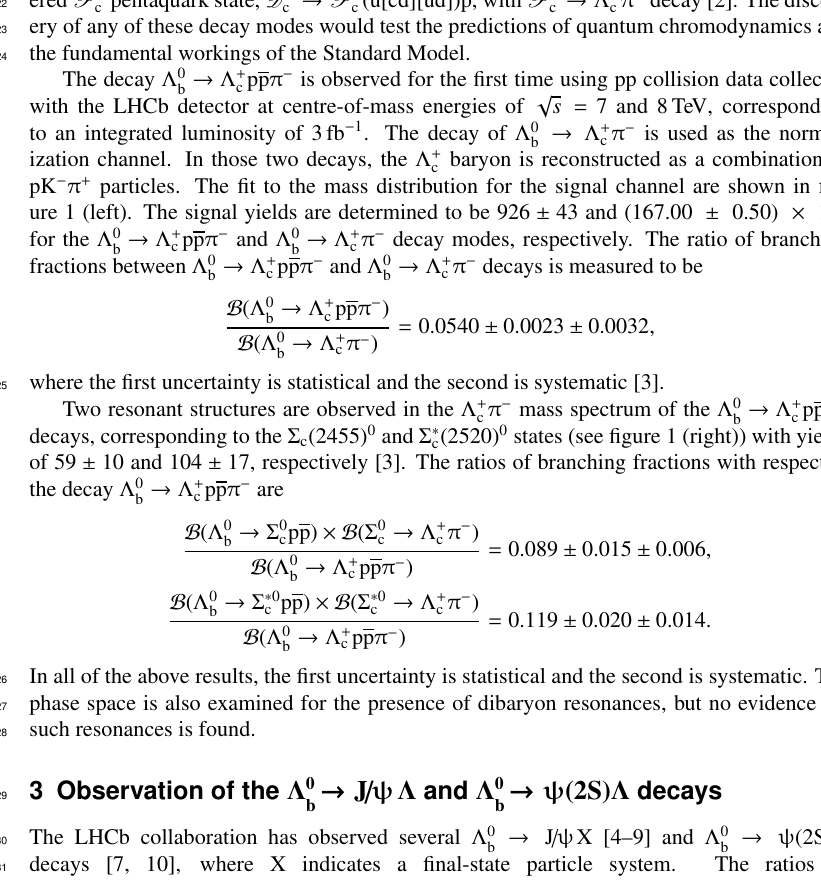
Λ + π − candidates and (right) of the Λ + c pp b → 0 resonances are indicated. The fit to the data is c (2520)